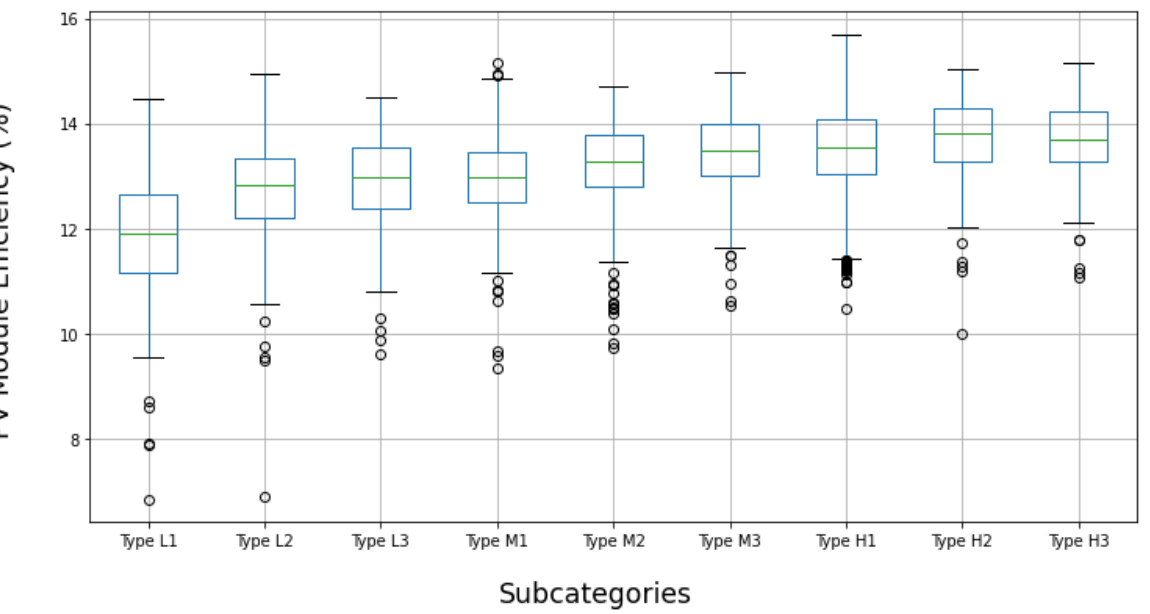
Figure 11. Average daily efficiency of PV modules in the clusters L1, L2, L3, M1, M2, M3, H1, H2 and H3.